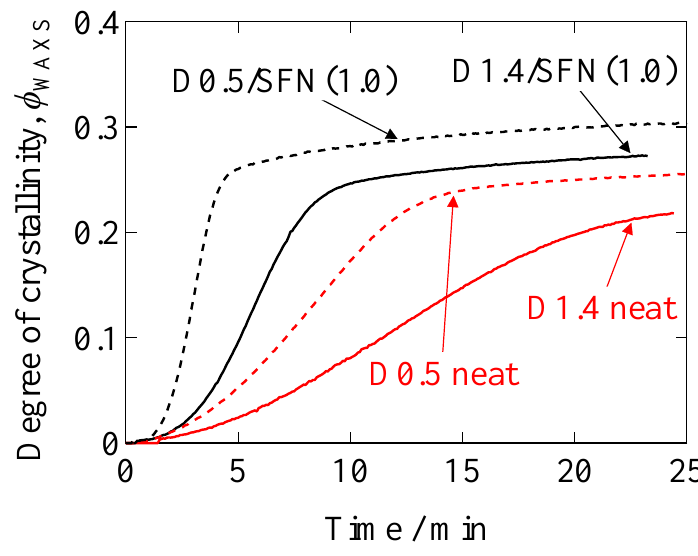
Figure 2. Degree of crystallinity as a function of time for the isothermal crystallization at 110 °C. Table 2. WAXS results for the isothermal crystallization at 110 °C .